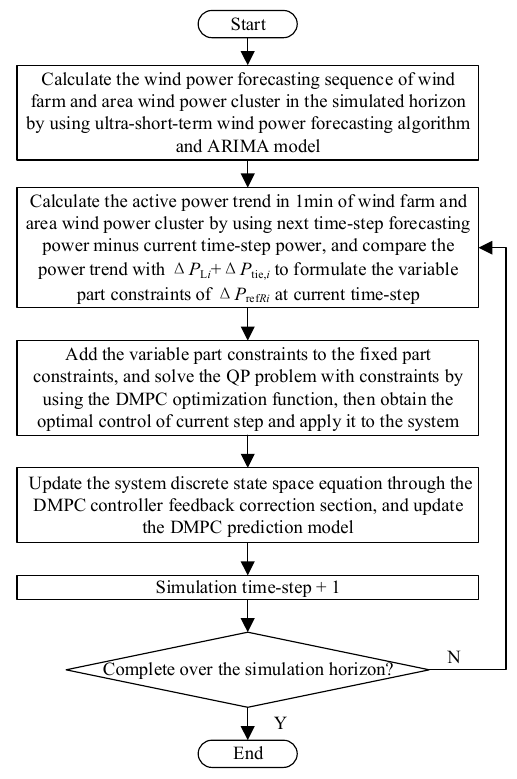
Figure 2. Procedure diagram of DMPC control strategy.